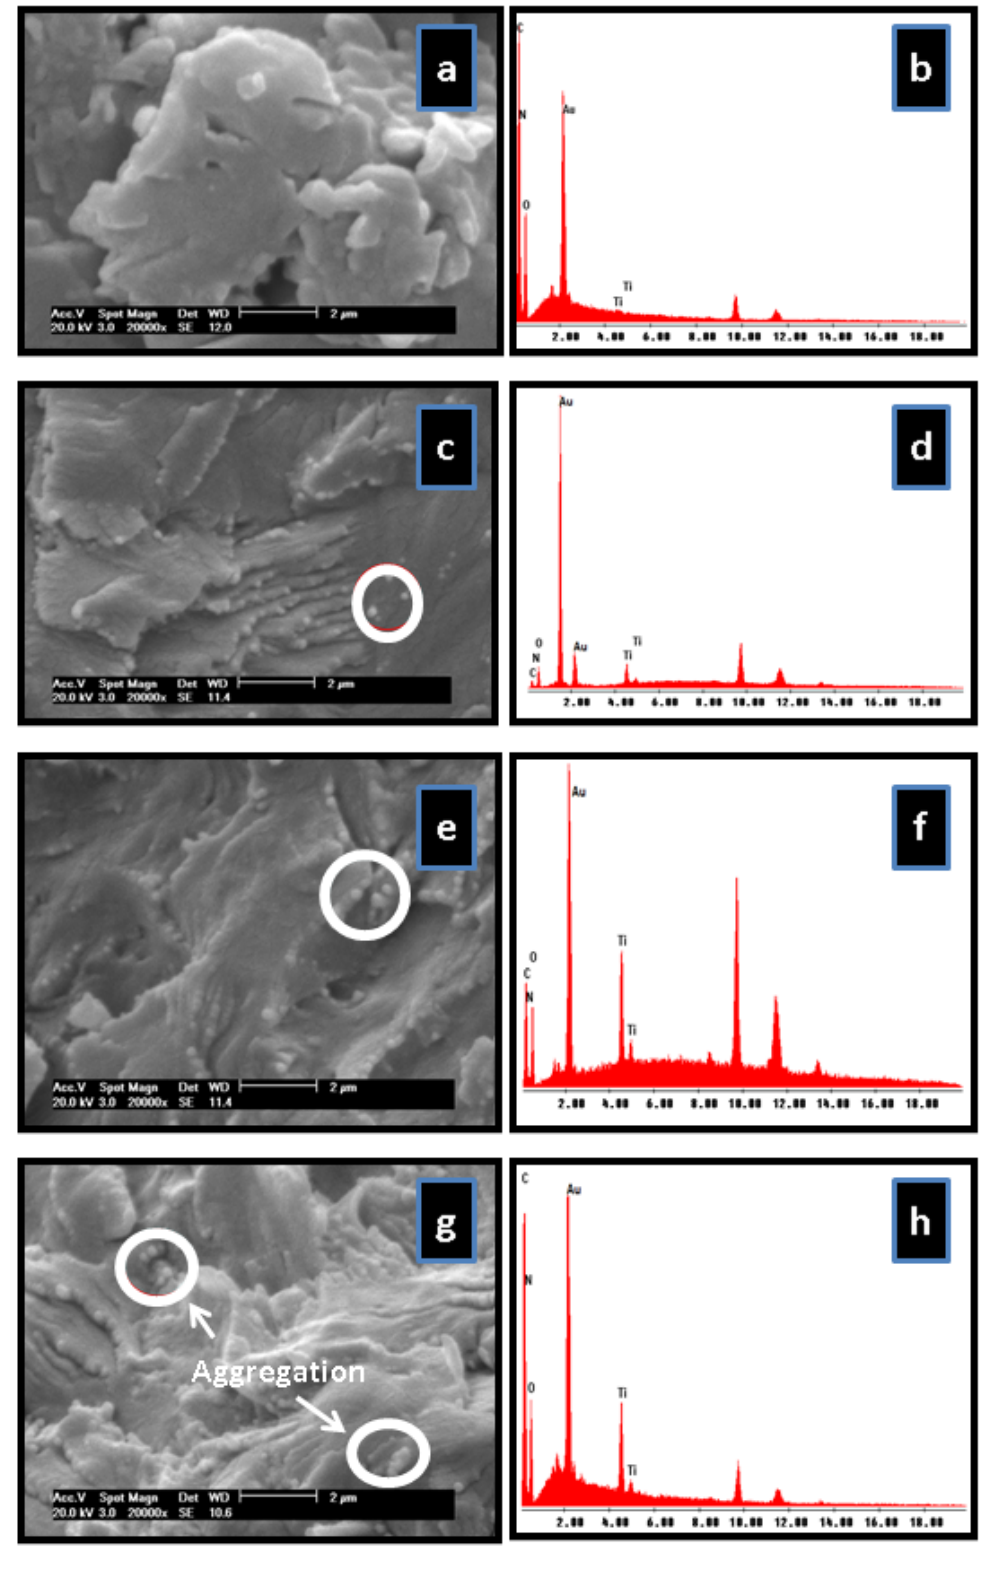
Fig. 6. Micrographs of the pure polymer (a); APE with 1% (c); 3% (e) and 5% TiO 1% (d); 3% (f) and 5%